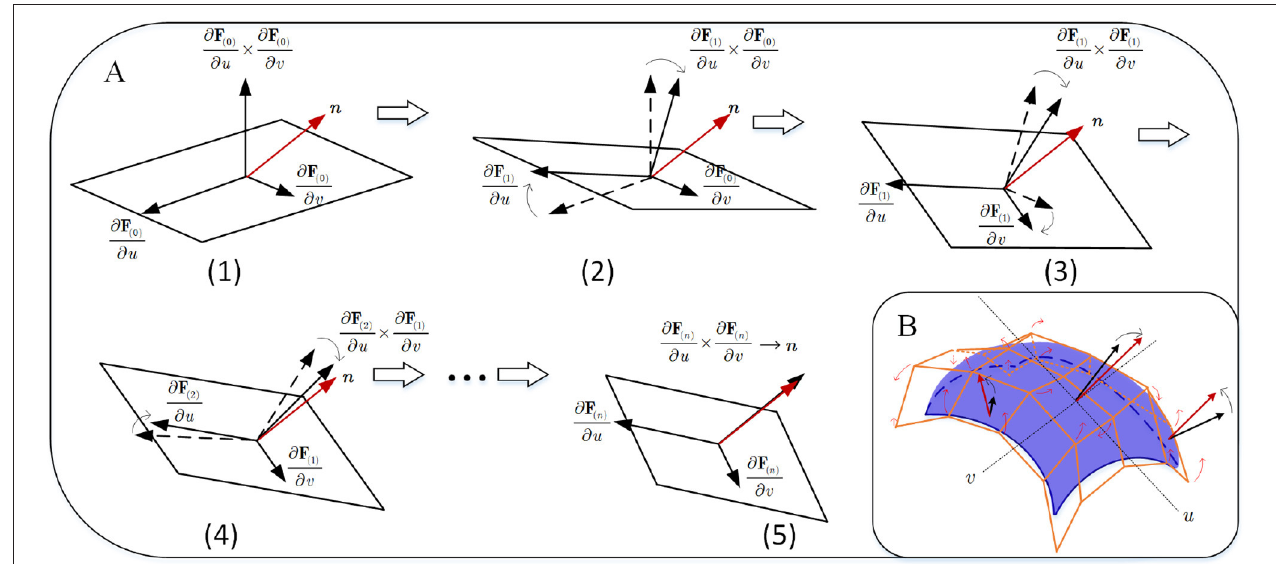
∂ F by fixing ∂ F ∂ , … until that ∂ F ∂ ∂ v v u u ×